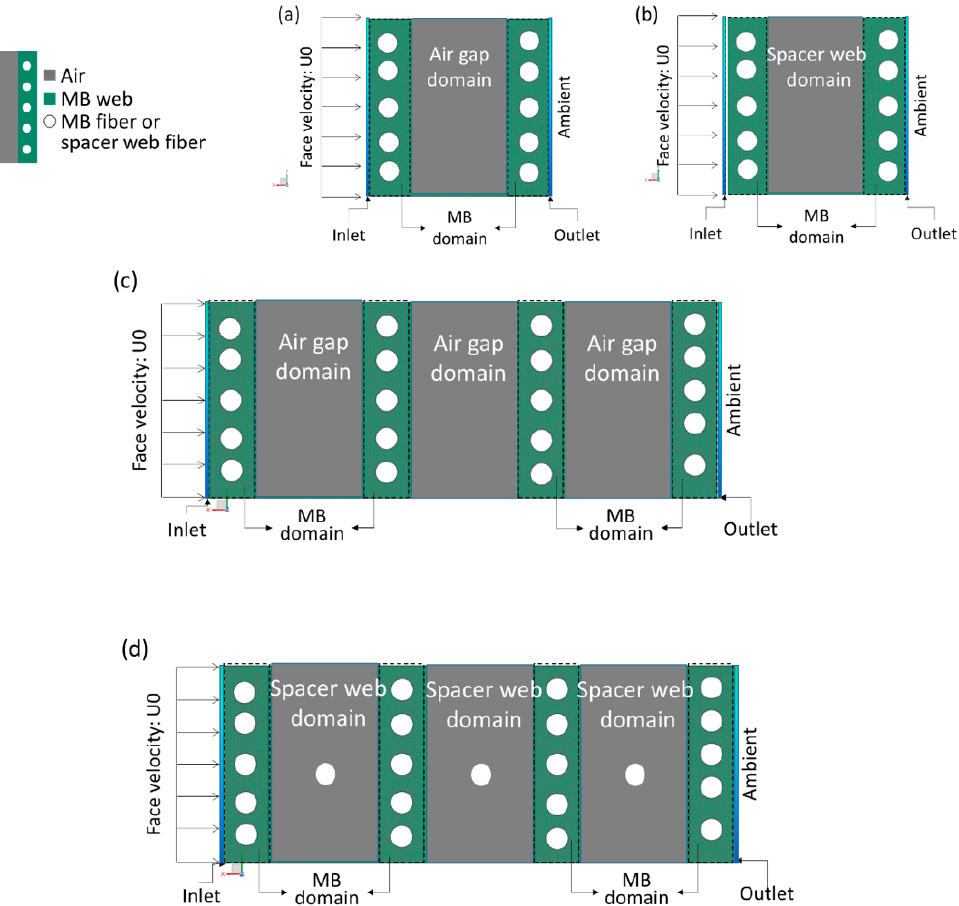
Figure 3. Developed computational fluid dynamics models of given filter constructions. ( a ) 2 MB layers and 1 air gap, ( b ) 2 MB layers and 1 space web, ( c ) 4 MB layers and 3 air gaps, ( d ) 4 MB layers and 3 spacer